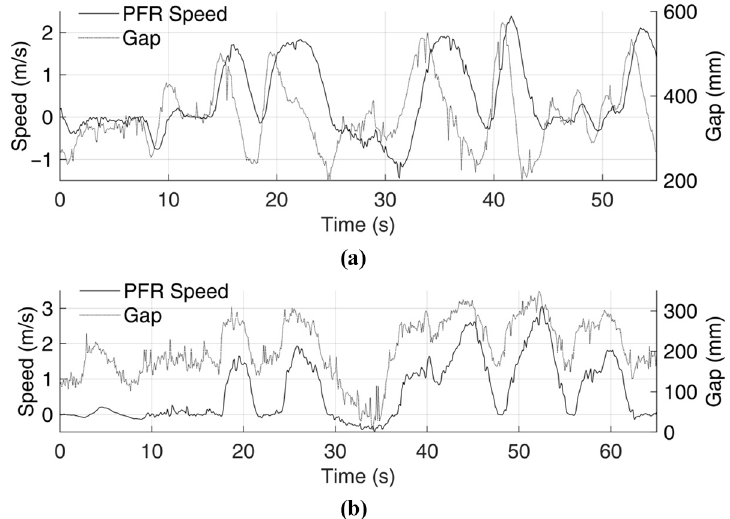
Figure 8 The following gaps and PFRs speeds of test records: (a) the linear model; (b) the